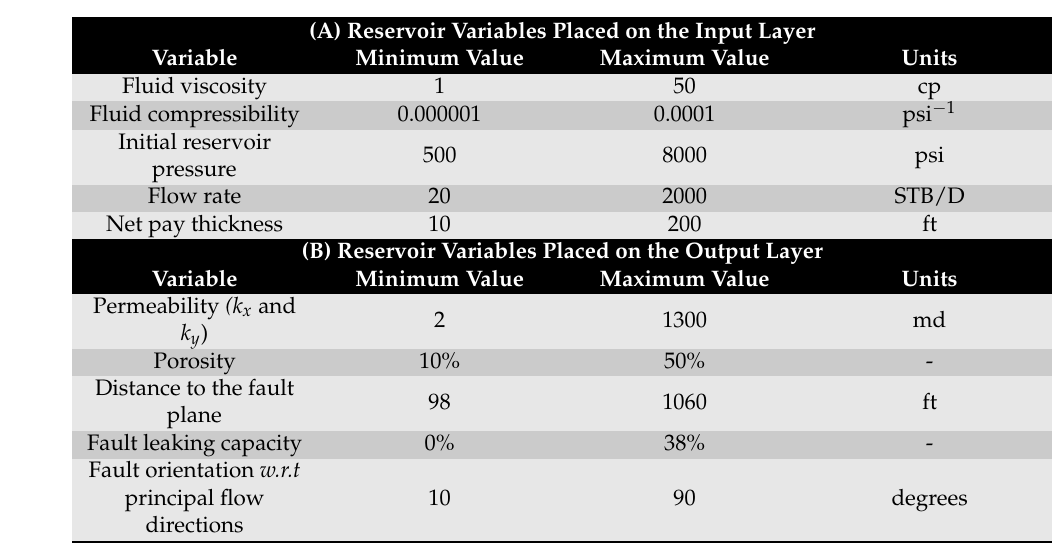
Table 2. Ranges of variables placed on the input (A) and output (B) layers [9].